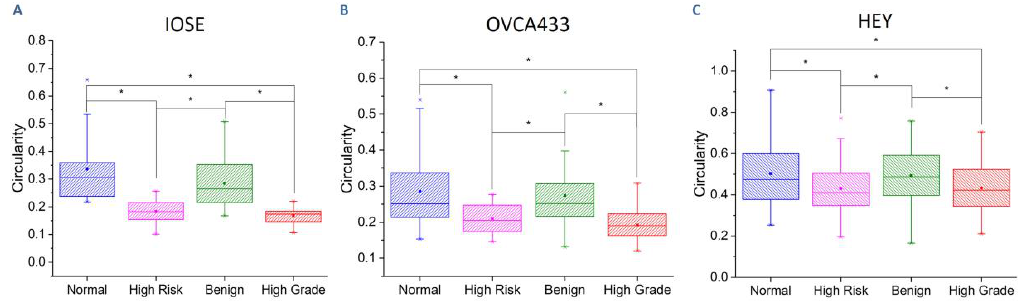
Figure 5. Cell circularity for IOSE ( A ), OVCA433 ( B ), and HEY ( C ) cells on image-based patterns (* p < 0.05).